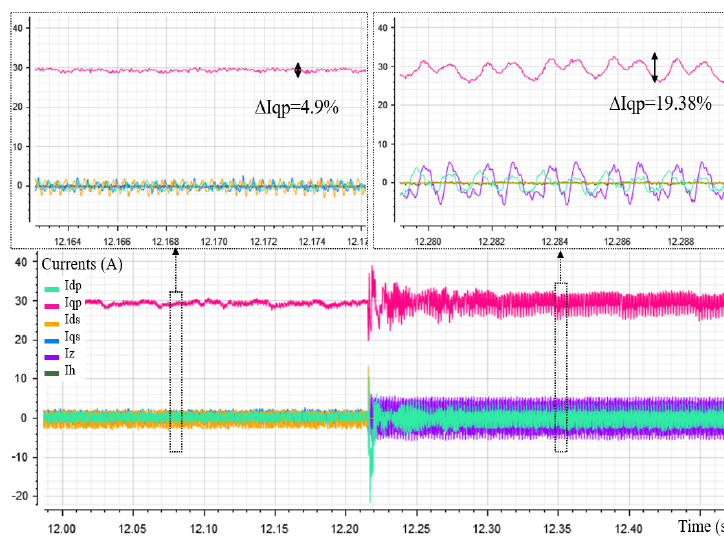
Figure 12. Phase currents before and after the fault on phase A.